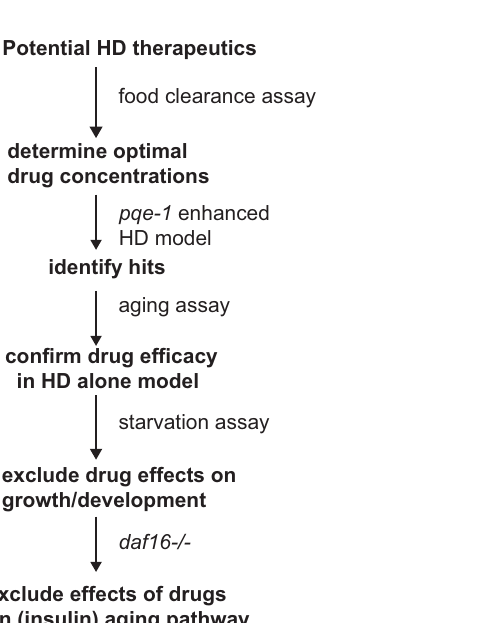
Figure 5. Schematic Diagram of Compound Testing Strategy. (1) A range of concentrations for each compound for testing in C. elegans was established using the food clearance assay. (2) The protective effects of compounds on polyglutamine neurodegeneration and cell death were assessed in pqe-1;Htn-Q150 animals treated with com- pounds for 3 days. (3) To determine if neuroprotective effects of compounds were dependent on pqe-1 , compounds were retested in animals expressing Htn-Q150 for 7 days. (4) To distinguish drug effects on neuronal cell death versus effects on growth and/or development, synchronized pqe-1;Htn-Q150 L1 animals were incubated in the presence of drugs without food for 2 days. (5) The neuroprotective effects of compounds on the aging process can be tested by introducing mutations ( daf-16 ) in components of specific aging-related (insulin signaling)